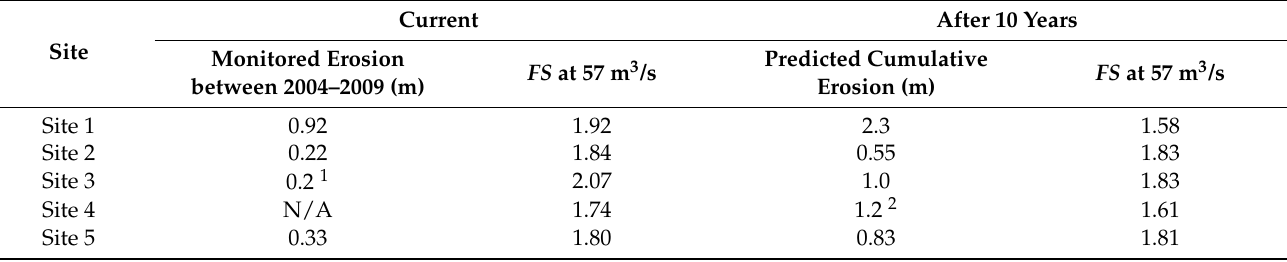
Table 6. Erosion rate calculated from USGS erosion pin